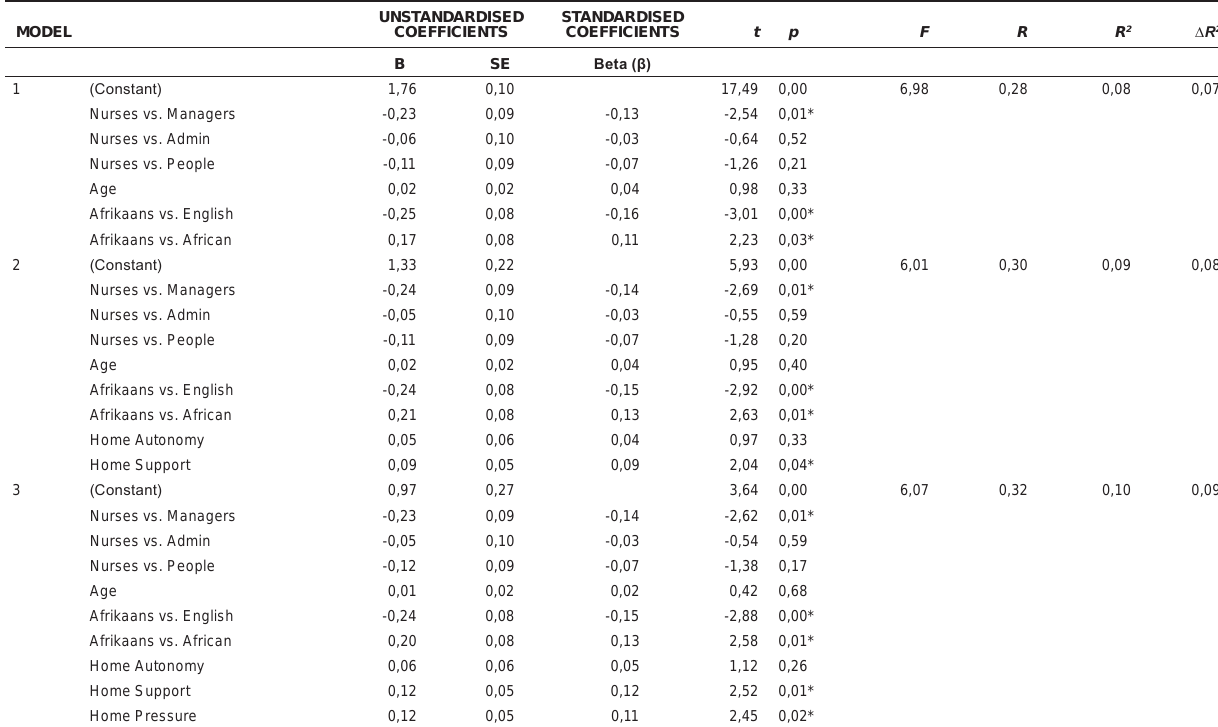
taBLe 7 Multiple regression analyses with positive HWI as dependent